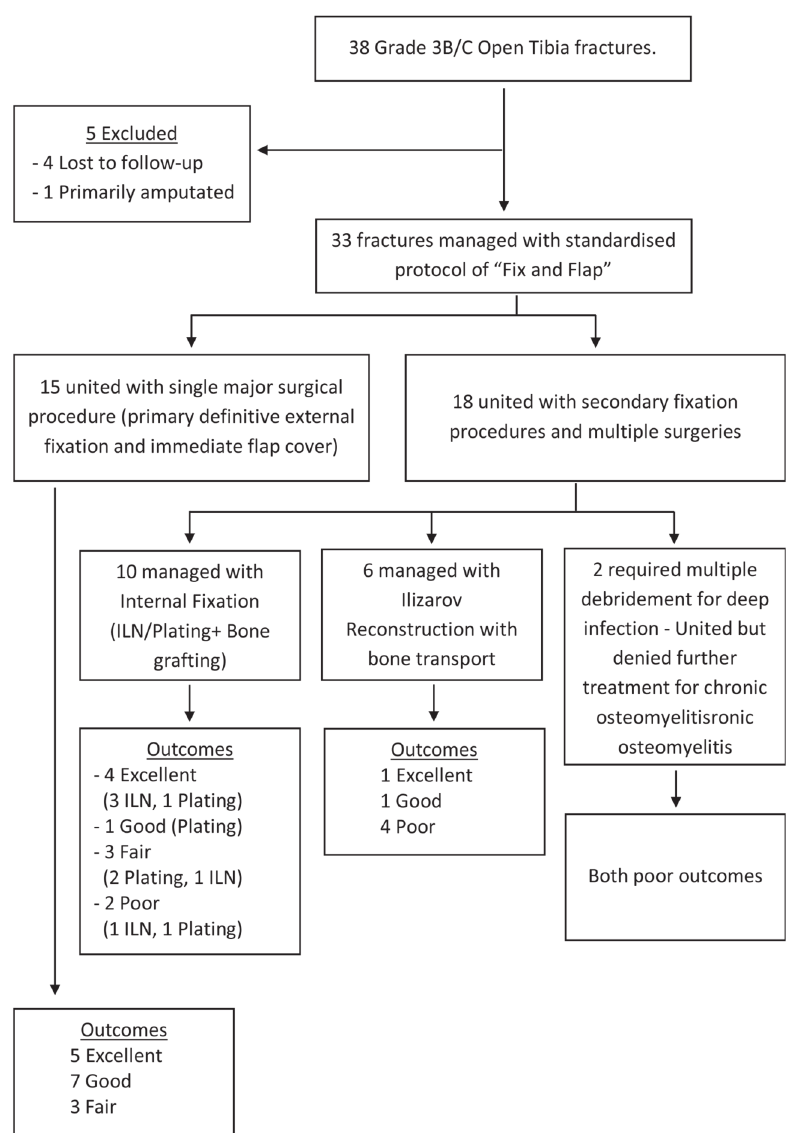
Flow chart showing outcomes of various surgical Fig. 9: